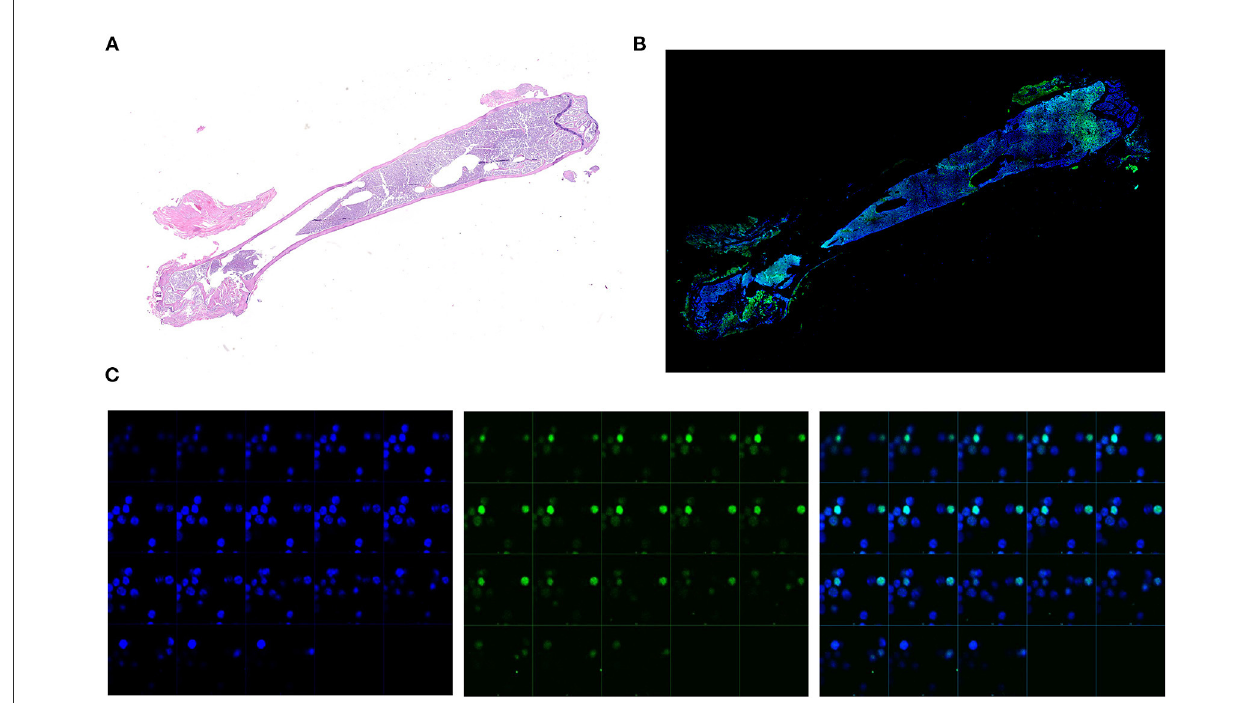
FIGURE2 Representative analyses of the GFP levels expressed by the single cells from the BM of an untreated double mutant female mouse (11-months old). (A) Reconstruction of the whole femur from the representative double mutant mouse stained by Hematoxylin/Eosin. Scanning was performed with a resolution equivalent to that of a x40 objective. (B) Reconstruction of the whole femur from the same representative double mutant mouse shown in A stained with DAPI by confocal microscopy. The original images were acquired at x200 magnification. Blu = DAPI, Green = GFP. (C) Zeta stacking (each photogram a different focal plane) at X400 magnification of images collected by confocal microscopy in order to confirm the nuclear colocalization of both the DAPI and the GFP signal. Two representative GFP positive cells are shown. Images are presented as individual DAPI (left panels) and GFP (central panels) and as merged (right panels)